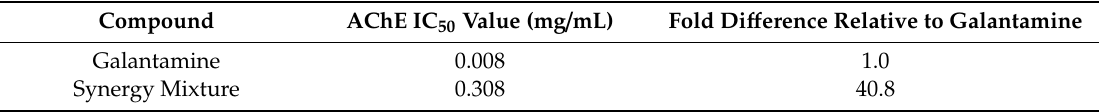
Table 5. Synergy mixture IC 50